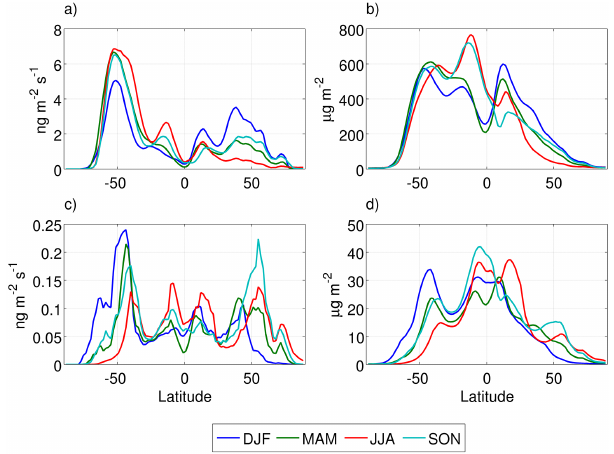
Figure 4. Seasonal zonal means of (a) emissions of sea salt, (b) burden sea salt, (c) emissions of primary marine or- ganic matter, and (d) burden of primary marine organic mat- ter. DJF, MAM, JJA, and SON stand for mean over